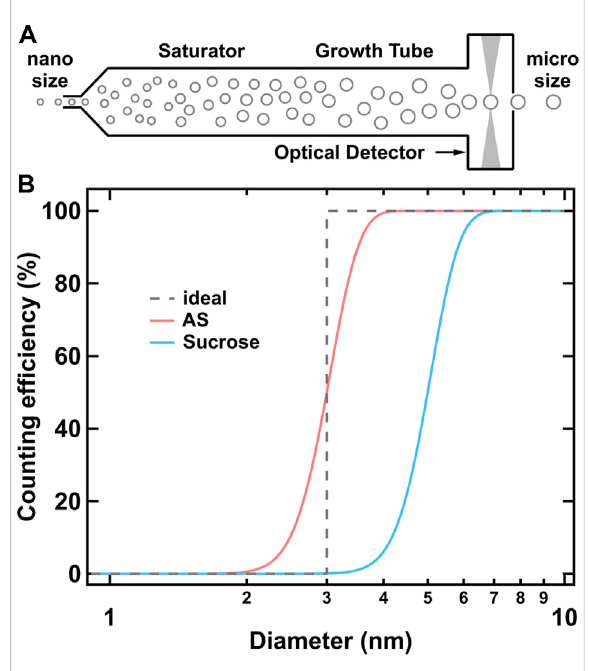
FIGURE 2 (A) Schematic of condensation growth of